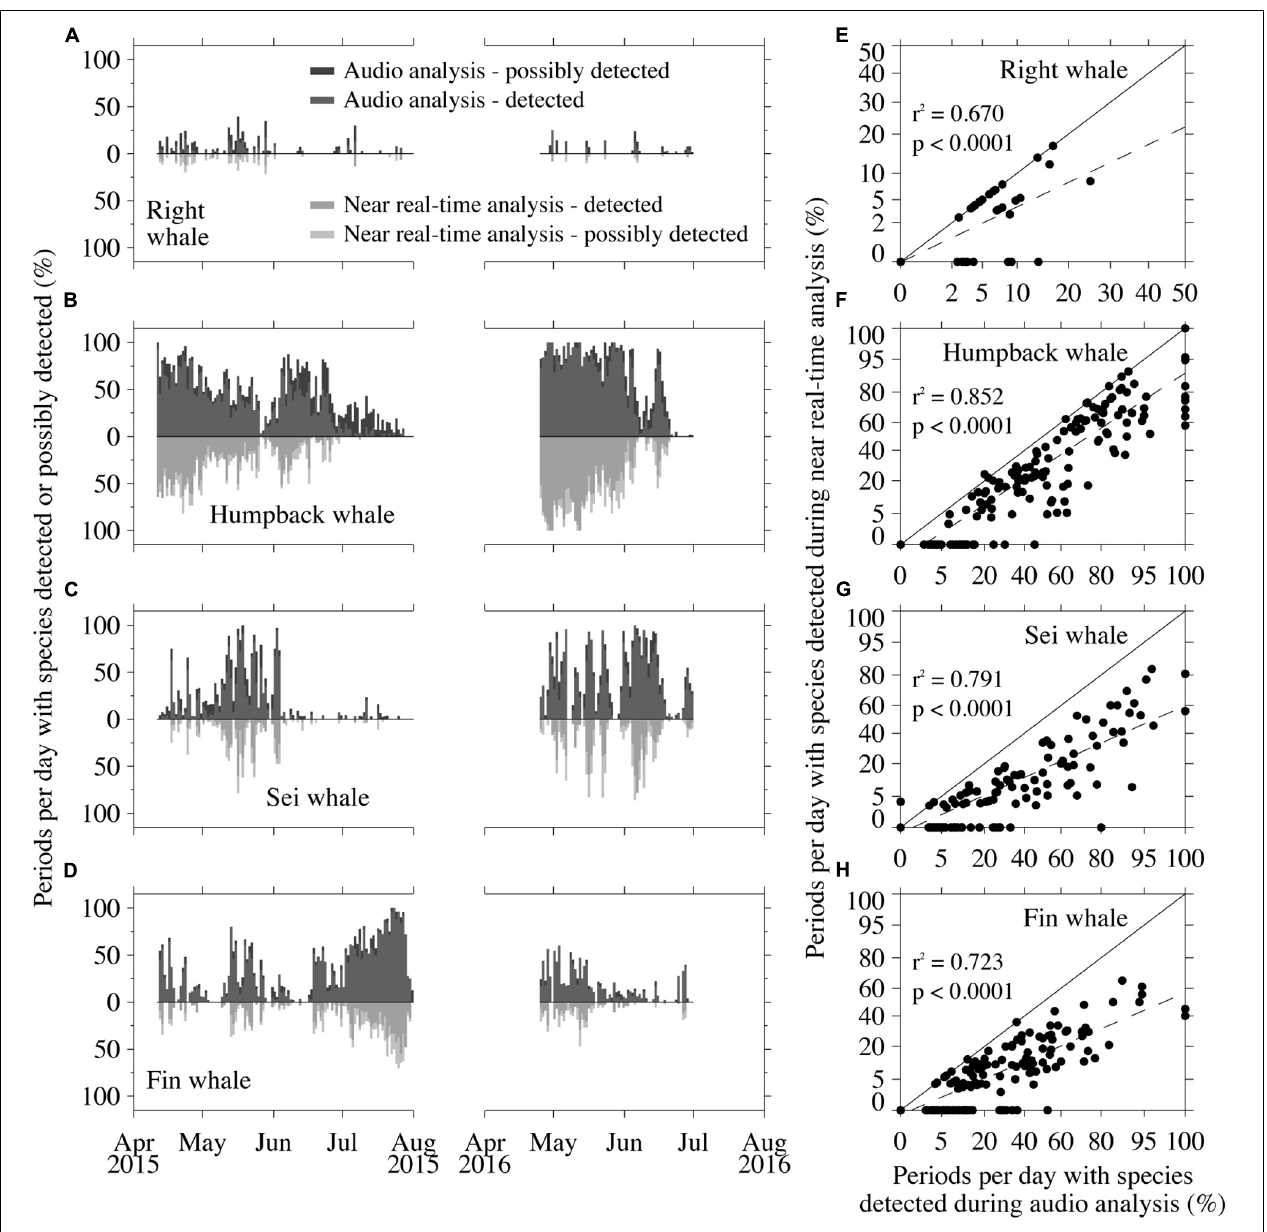
FIGURE 4 | Time series of daily detections derived from the retrospective audio analysis (above zero line) and daily detections derived from the near real-time analysis (below zero line) for (A) right, (B) humpback, (C) sei, and (D) fin whales. Detections and possible detections are shown for both analyses. Scatterplots of near real-time versus retrospective audio detections for (E) right, (F) humpback, (G) sei, and (H) fin whales. Coefficients of determination ( r 2 ) and associated p values are shown as well as a 1:1 line (solid) and simple linear regression line